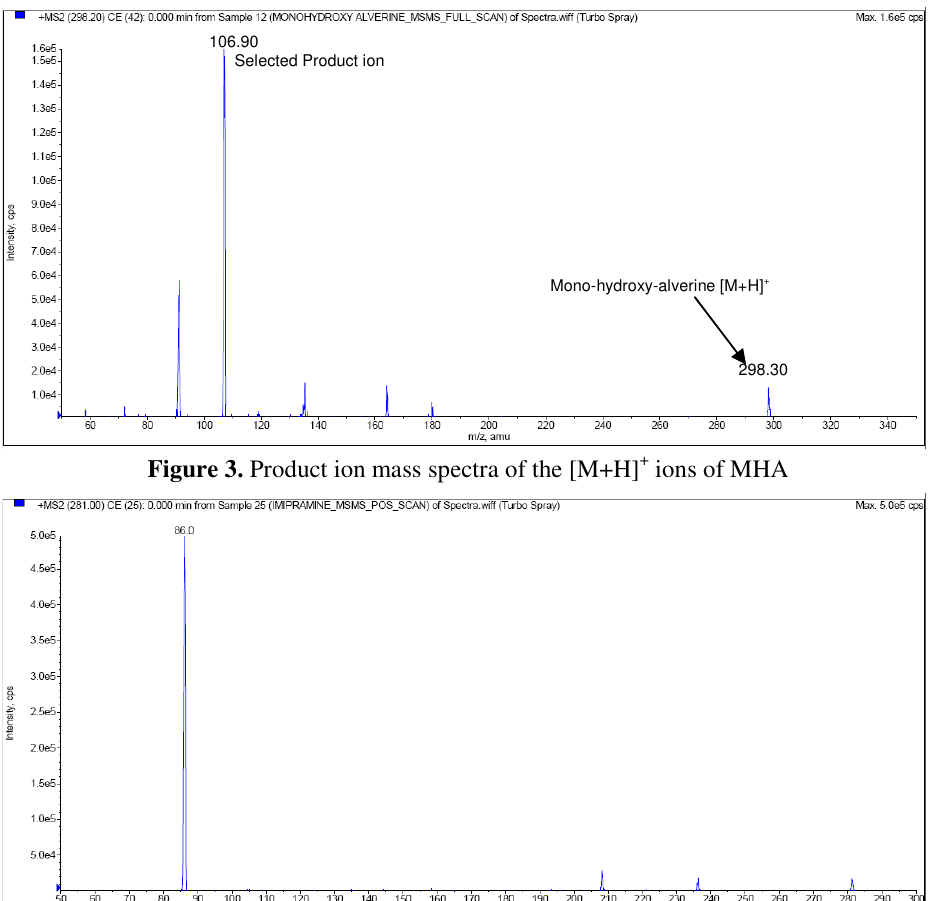
Figure 3. Product ion mass spectra of the [M+H] + ions of MHA